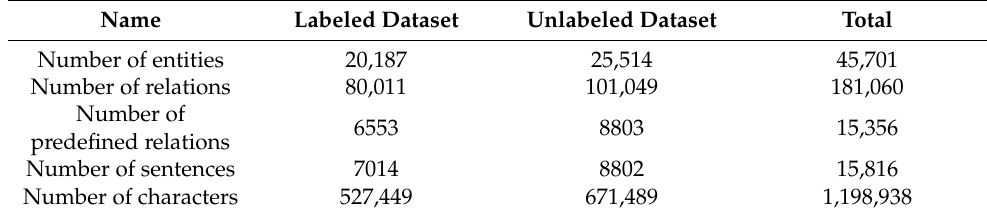
Table 8. The data statistics of the geological KG in the